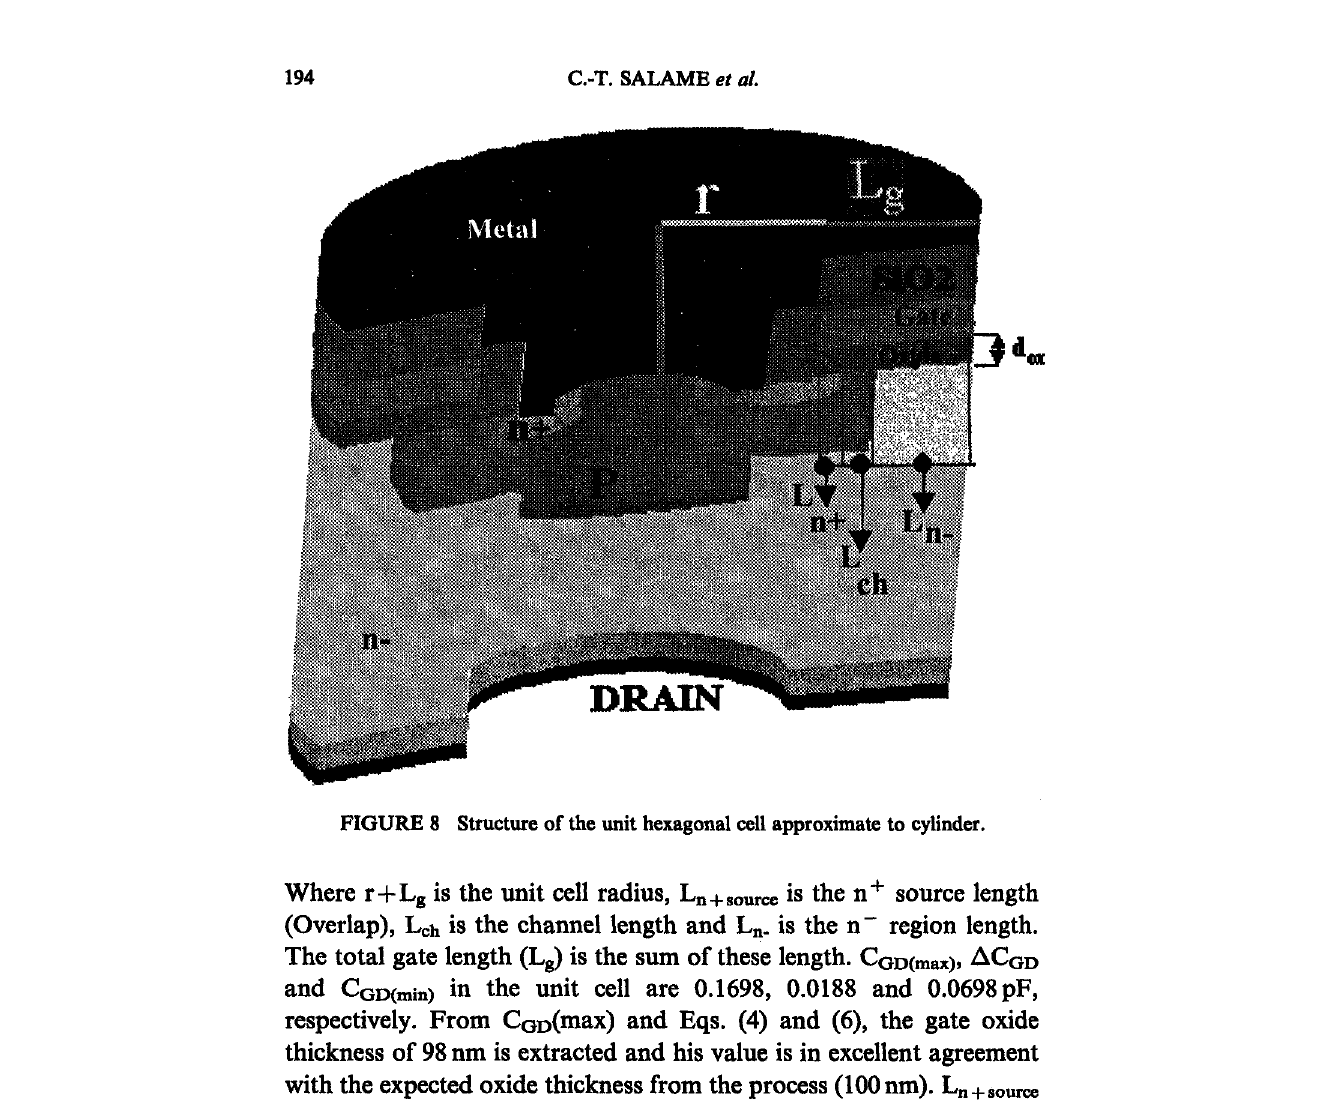
TABLE I The comparison of the real dimensions and the extracted